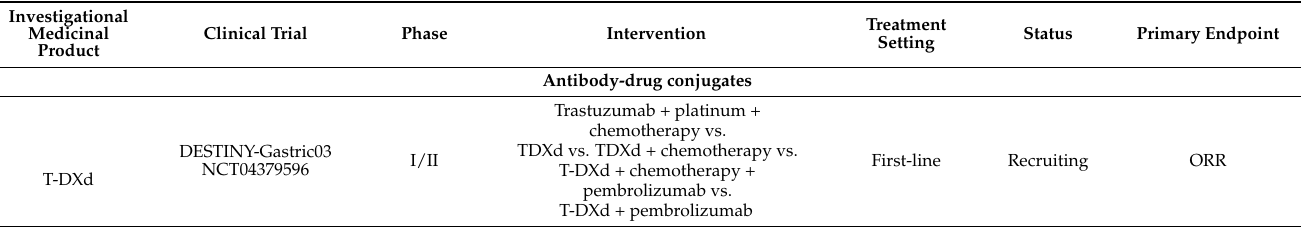
Table 2. Selected HER2-targeted therapies undergoing clinical trial